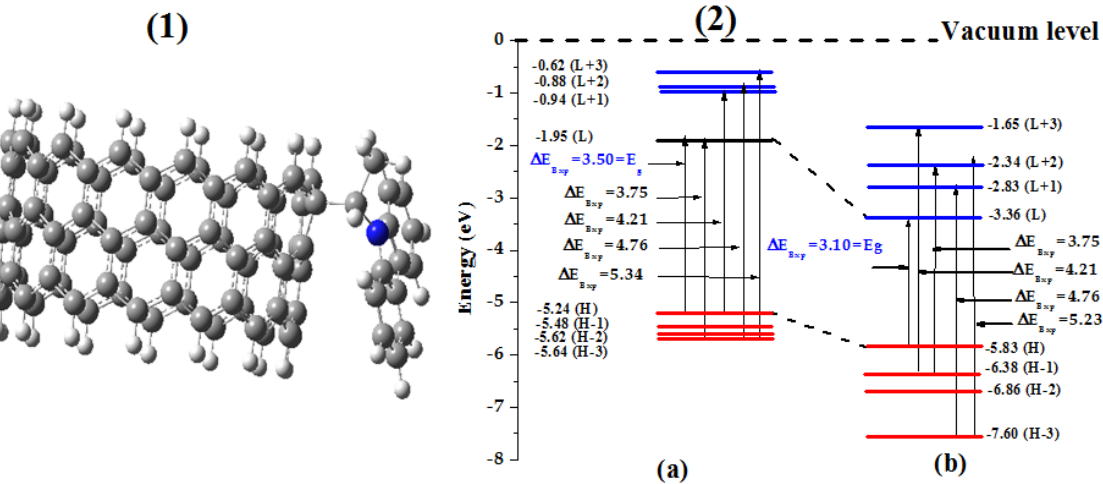
Figure 6. ( 1 ) Nanocomposite modeling structure used for DFT calculation and ( 2 ) change in the electronic structure from OVK ( a ) to the nanocomposite ( b ). H: HOMO; L: LUMO; Exp: experi- mental.